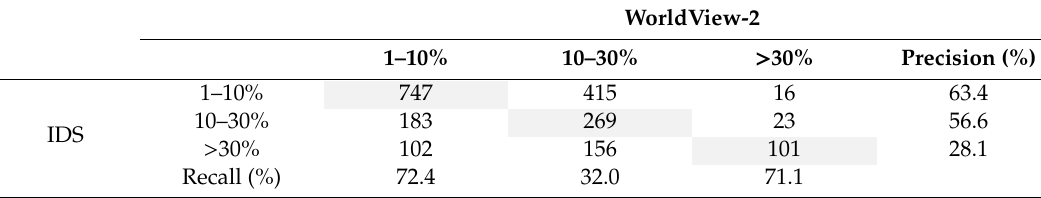
Table A5. Comparison of percent tree mortality area derived from 2018 WorldView-2 and IDS polygons (2014–2018 cumulative). IDS trees per acre measurements were converted to percent mortality using the FHAAST method. Overall accuracy = 55.5%, N = 2012.